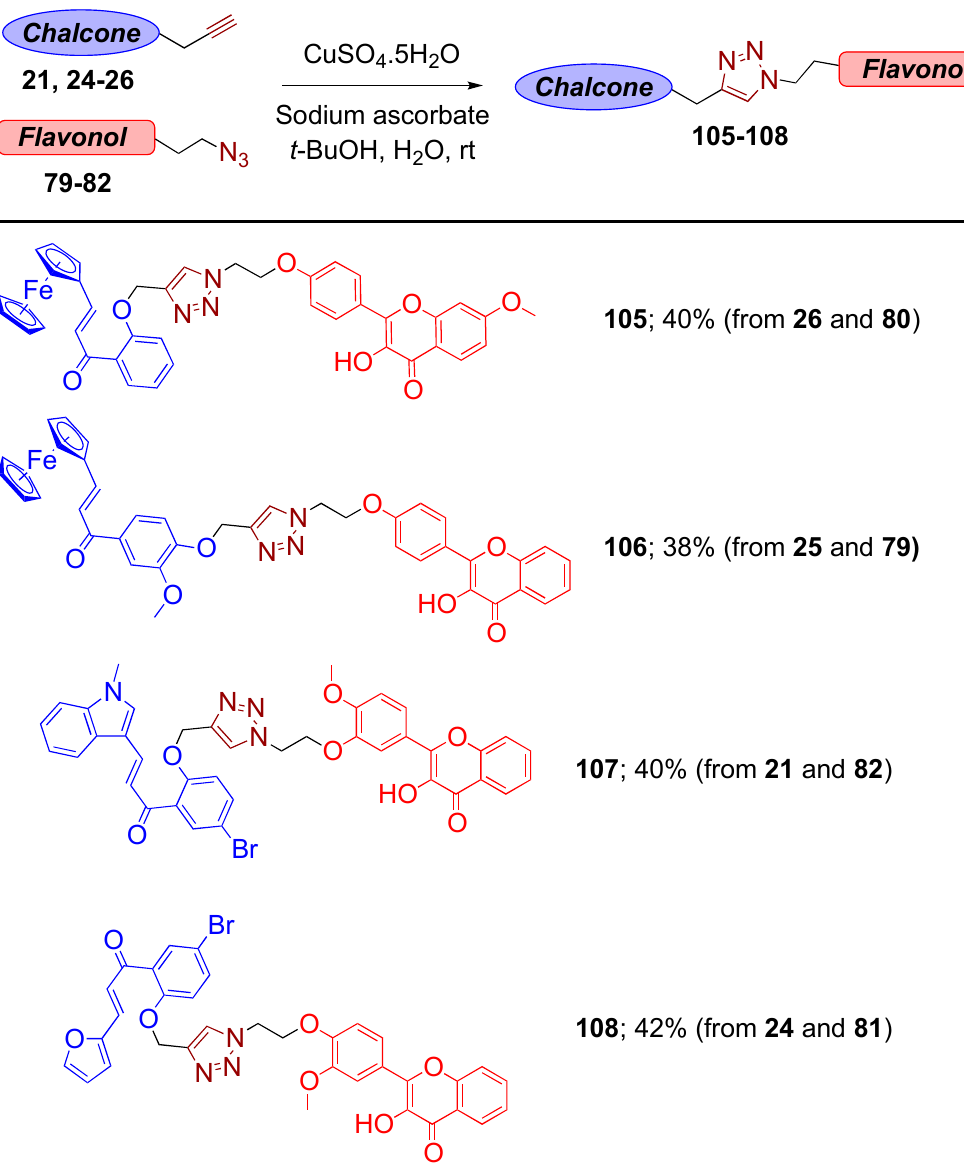
Scheme 18. Synthesis of triazole-bridged chalcone-flavonol